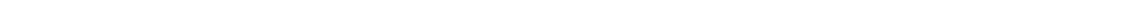
Figure 1 | Development of an MDS-like disease in Asxl2 (cid:2) / (cid:2) mice. ( a ) Parameters of PB were summarized from WT, Asxl2 þ / (cid:2) and Asxl2 (cid:2) / (cid:2) mice at 6–8 weeks of age (six mice per genotype). ( b ) May–Gru¨nwald–Giemsa stained PB smears from representative WT, Asxl2 þ / (cid:2) and Asxl2 (cid:2) / (cid:2) mice were shown. The PB smears of Asxl2 þ / (cid:2) and Asxl2 (cid:2) / (cid:2) mice showed dysplastic features, including hyposegmented (bilobed) NEs with fine nuclear bridging consistent with pseudo Pelger–Hue¨t, asymmetric nuclear structure and increased number of polychromatophilic red blood cells (RBCs) and Howell–Jolly bodies in erythrocytes. Scale bar, 10 m m. ( c ) Haematoxylin and eosin (H&E) stained sections of femurs (upper panels) and May–Gru¨nwald–Giemsa stained cytospins (lower panels) from representative WT, Asxl2 þ / (cid:2) and Asxl2 (cid:2) / (cid:2) mice (6–8 week old). Scale bar, 10 m m. ( d ) Enlarged spleens in Asxl2 (cid:2) / (cid:2) mice. Shown are representative photographs of spleens of three sets of WT, Asxl2 þ / (cid:2) and Asxl2 (cid:2) / (cid:2) mice (6–8 week old), spleen/body weight ratio ( (cid:3) 100) and spleen cellularity for each genotype of mice (six mice per genotype). ( e ) H&E staining of paraffin-embedded sections of spleens from representative WT, Asxl2 þ / (cid:2) and Asxl2 (cid:2) / (cid:2) mice (6–8 week old). Red arrows indicate dysplastic cells. Scale bar, 100 m m. Data are presented as mean ± s.e.m. Comparisons among the groups were performed by one-way analysis of variance. * P o 0.05 and *** P o